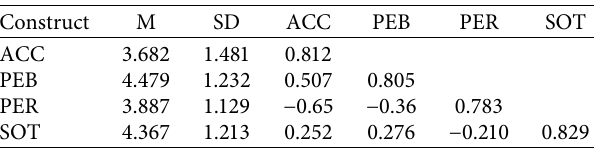
Table 6: Mean (M), standard deviation (SD), and correlation matrix (full sample).